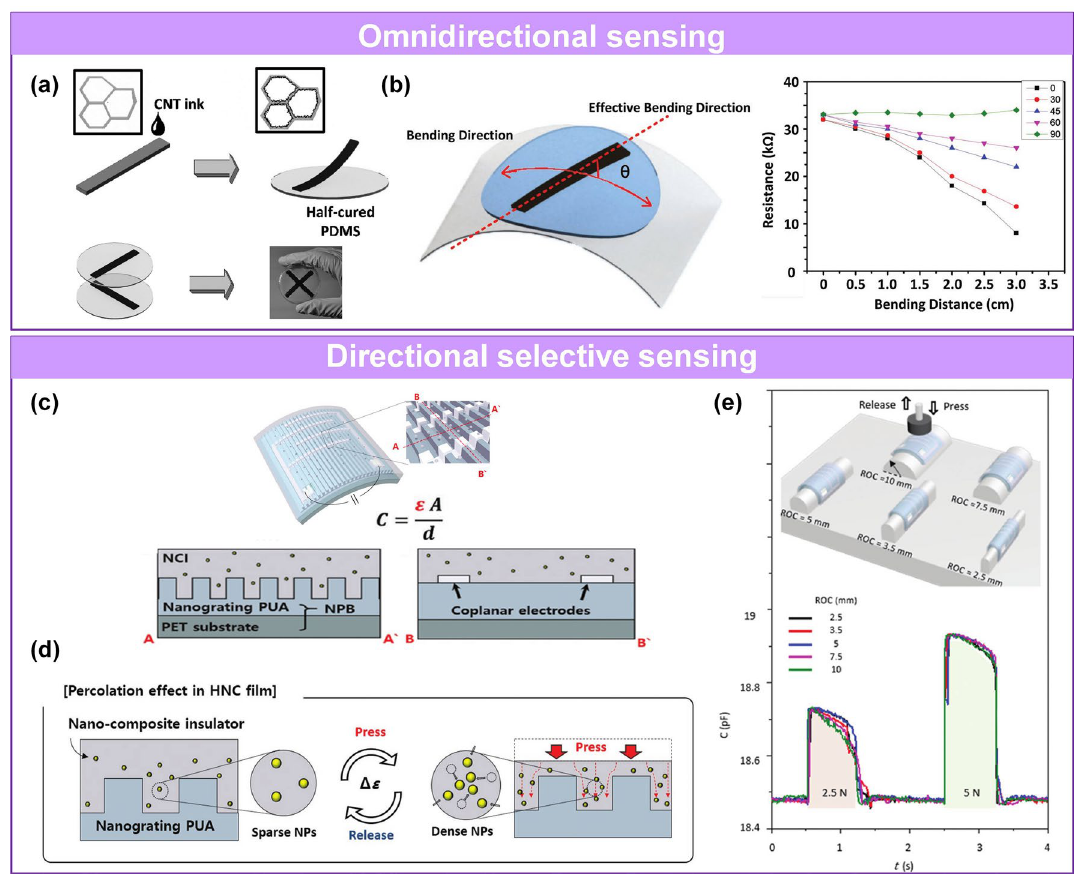
Fig. 12 Pressure sensors toward directional-selective sensing. a Fabricated process and b working principle of two orthogonal CPSS-based bending sensor [70]. Copyright (2016) Wiley–VCH. c Schematic illustration of the bending-insensitive sensor based on coplanar electrodes. d Schematic diagram of dielectric material variation under pressure. e Bending test under certain pressure [227]. Copyright (2018)